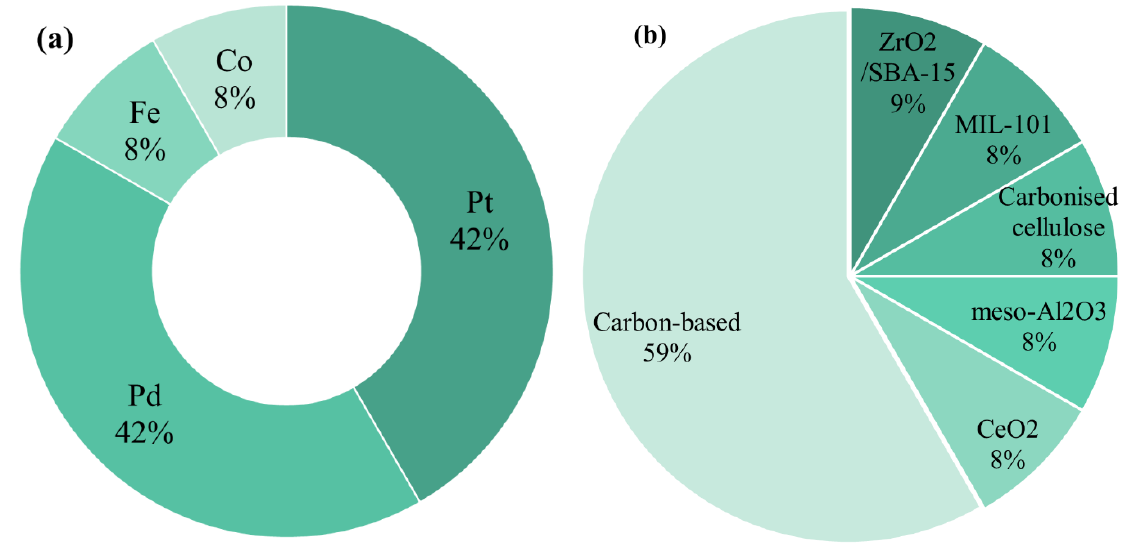
Figure 12. Distribution of active metals ( a ) and type of catalyst carriers ( b ) in D1 classified